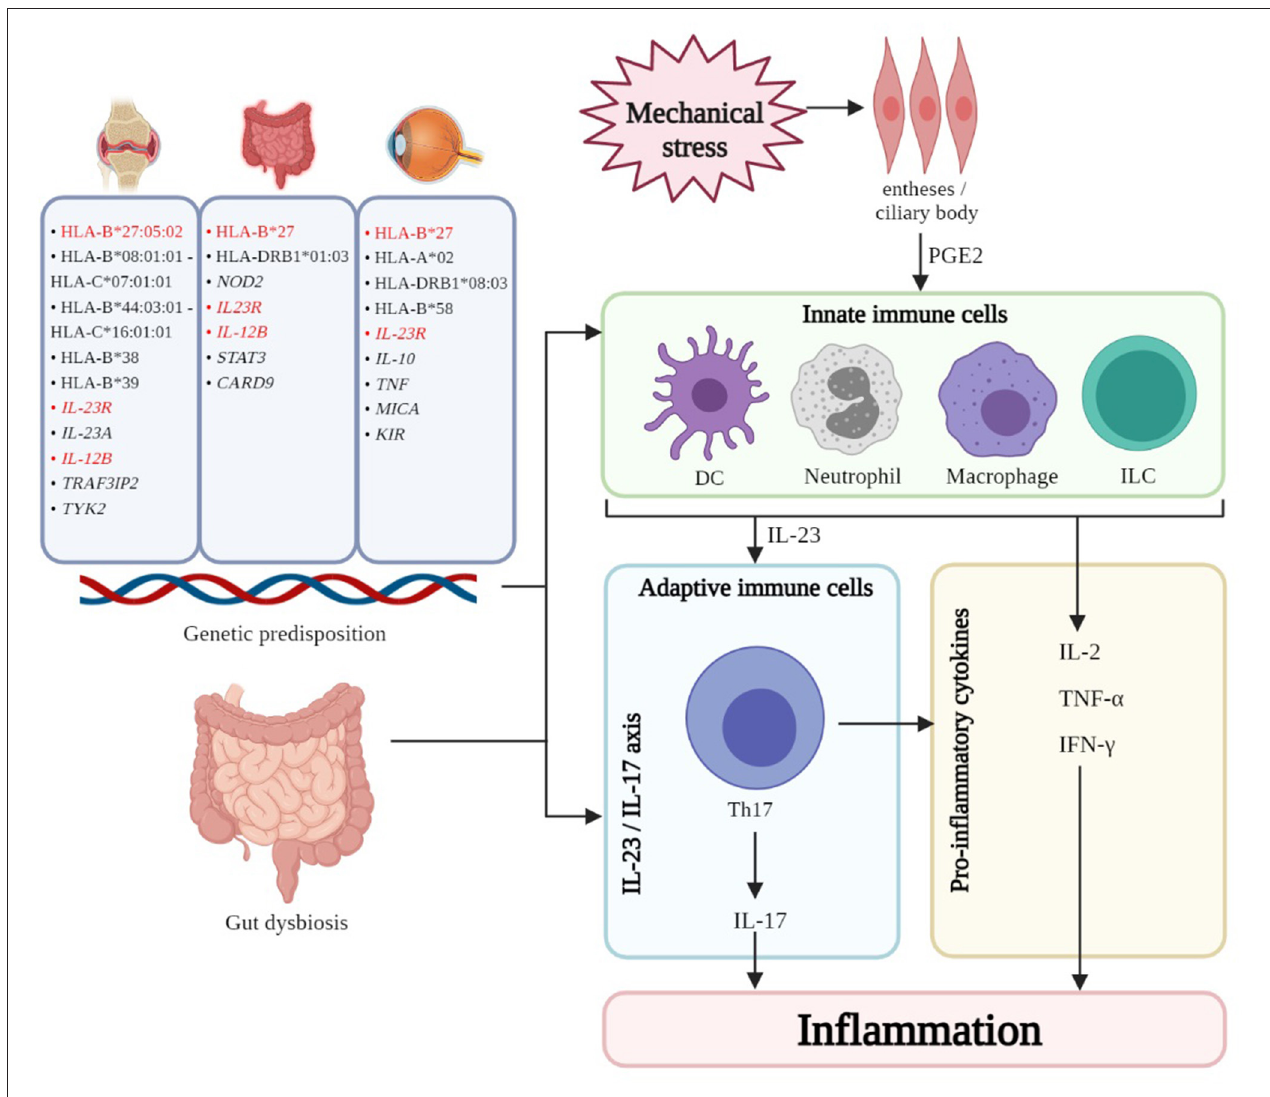
FIGURE 1 | The interplay of genetic, immune, and other factors results in inflammation of the various domains - skin, joints, gut, and eye - in PsD. Common genetic associations (highlighted in red) can be found amongst the three manifestations. Gut dysbiosis is thought to contribute to the pathogenesis for the three manifestations by leakage of bacterial antigen into systemic circulation thereby resulting in inflammation and/or trafficking of immune subsets to and from the GI mucosa and other sites. In PsA enthesitis and uveitis, mechanical stress triggers the release of PGE2, resulting in the recruitment and activation of innate immune cells (DC, neutrophils, macrophages, ILC like type 3 ILC, MAIT cells, γδ T cells) which perpetuate inflammation. Furthermore, these innate cells secrete cytokines, notably IL-23, which polarize and maintain Th17 cells which are central to the IL-23/IL-17 axis which is believed to be important in the pathogenesis of PsD. HLA, human leukocyte antigen; IL-23R , interleukin-23 receptor; IL-23A , interleukin-23A; IL-12B , interleukin-12B; TRAF3IP2 , tumor necrosis factor receptor-associated factor 3-interacting protein 2; TYK2 , tyrosine kinase 2; NOD2 , nucleotide-binding oligomerization domain-containing protein 2; STAT3 , signal transducer and activator of transcription 3; CARD9 , caspase recruitment domain family Member 9; TNF , tumor necrosis factor; MICA , major histocompatibility complex class I chain-related gene A; KIR , killer immunoglobulin receptor; DC, dendritic cell; ILC, innate lymphoid cell; MAIT, mucosal-associated invariant T cell; Th17, T helper 17 cell; IL-17, interleukin-17; IL-2, interleukin-2; TNF- α , tumor necrosis factor alpha; IFN- γ , interferon gamma. Created with